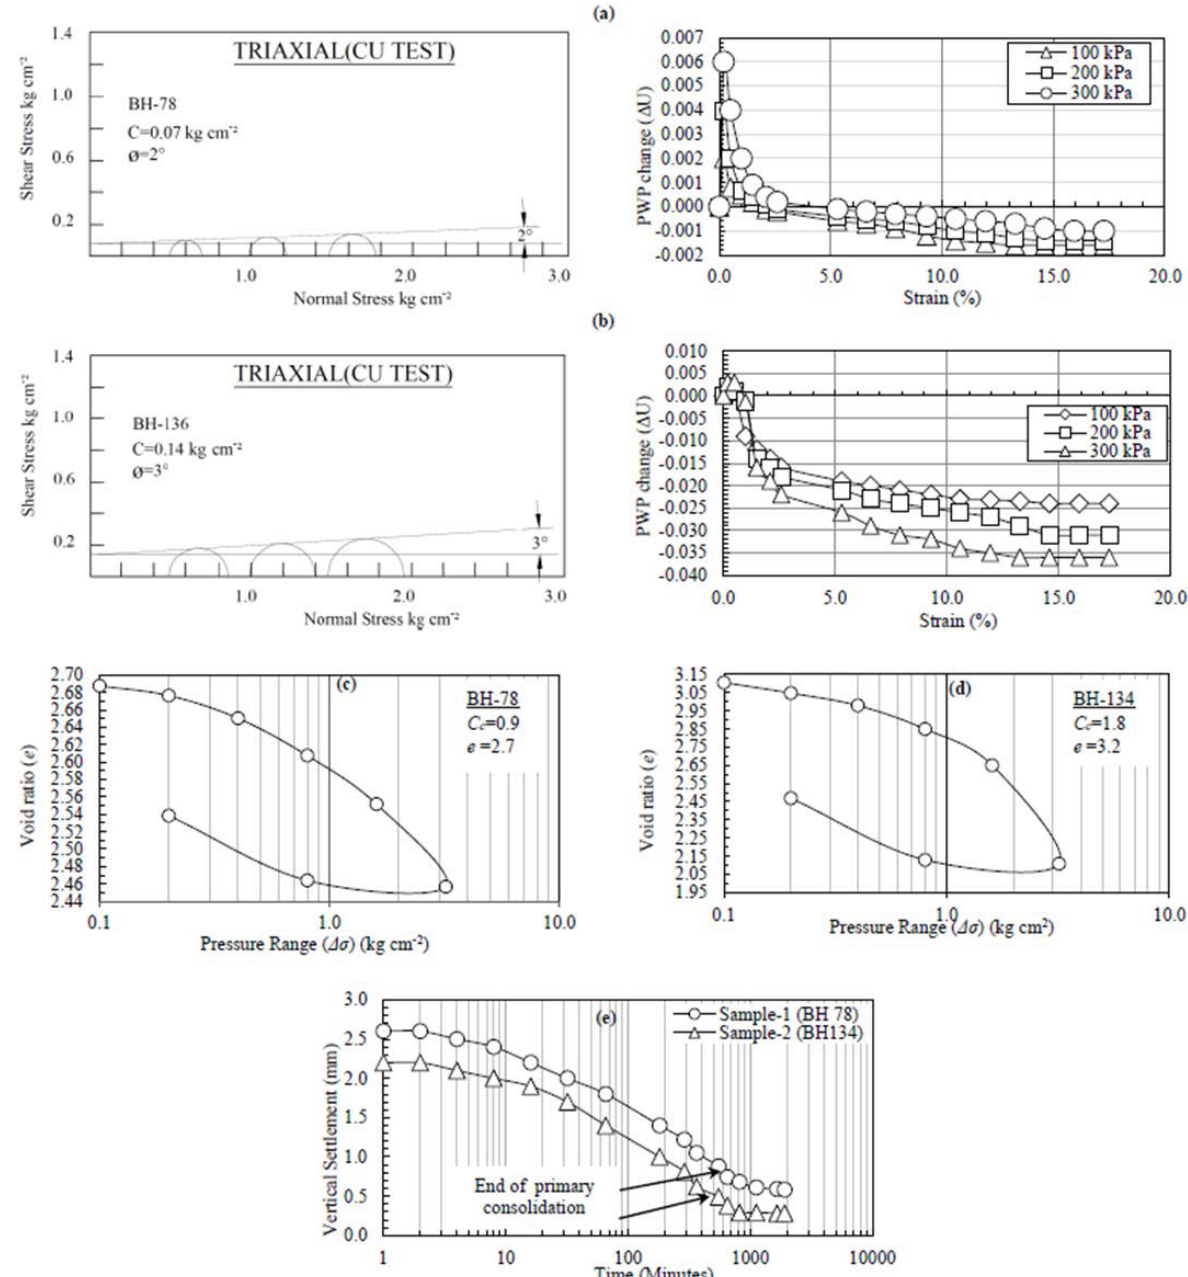
Figure 6. Sample graphs with static engineering parameters, shear strength parameters and measurements of pore water pressure (PWP) for peat samples collected from two sites in Agartala town, obtained from consolidated undrained triaxial (CUTX) test: (a) BH-79 and (b) BH-136; and settlement parameters from consolidation test: (c) BH 78, (d) BH 134 and (e) time settlement